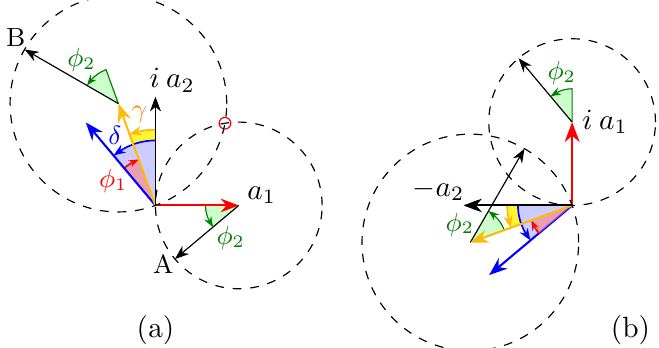
Figure 2. Phasor diagrams for the two components of A out ; actually, it shows the difference, not the sum, of the two terms of each component, as it is easier to visualise. ( a ) Top component of Equation (4). When the tips of the two vectors lie in the second intersection, circled in red, between the circumferences, then the first component of A out is zero. ( b ) Bottom